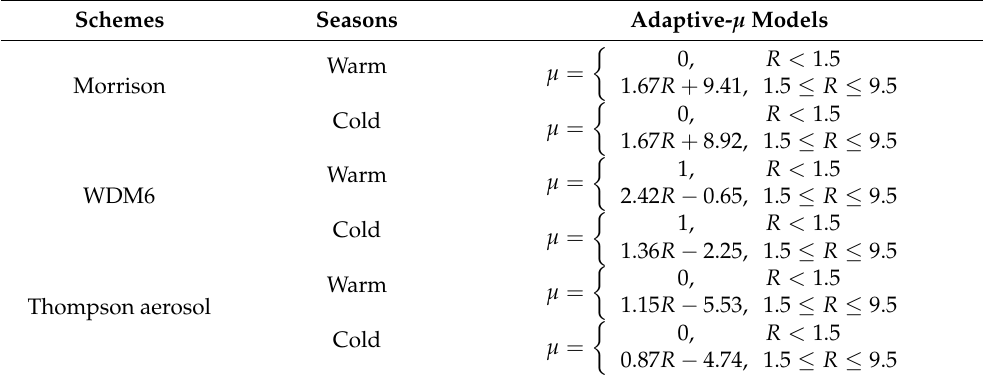
Table 2. Adaptive- μ models of the gamma RSD distribution in the WRF double-moment bulk mi- crophysical parameterizations of different scenarios.